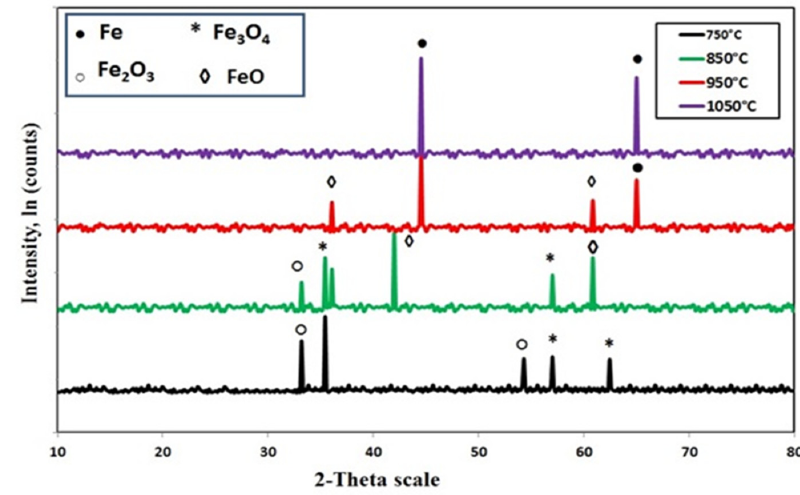
Figure 18. XRD patterns of the samples partially reduced by coal.